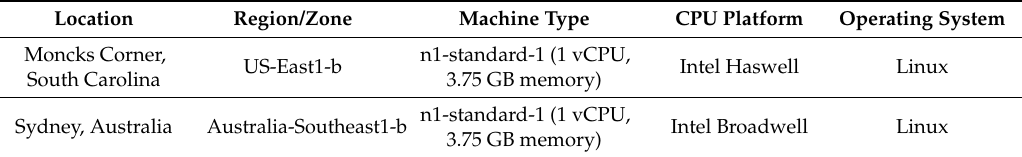
Table 5. Specifications of Google Compute Engine’s Virtual Machines (VMs) used for